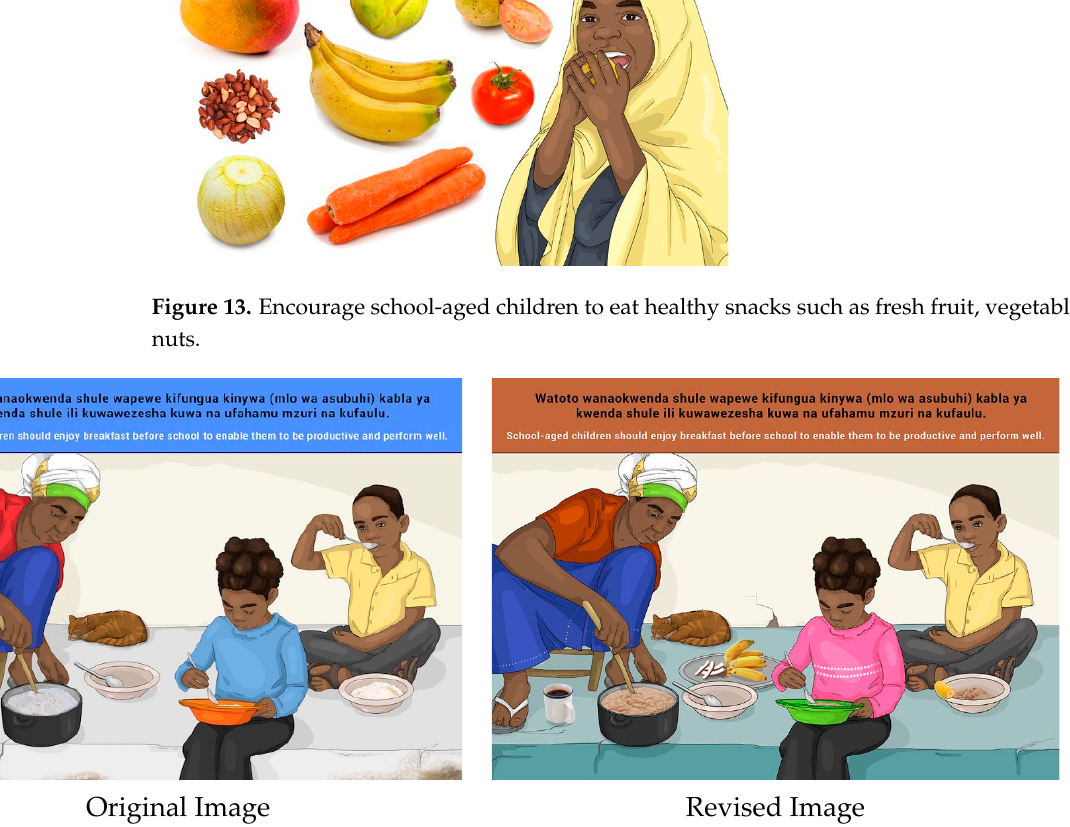
Figure 14. School-aged children should enjoy breakfast before school to enable them to be productive and perform well.